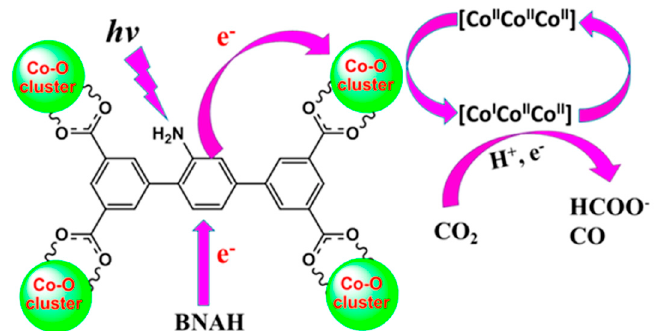
Figure 12. The mechanism of photocatalytic CO 2 reduction to HCOO − and CO, in the presence of amine-functionalized Co-MOF [Co 3 (HL) 2 × 4DMF × 4H 2 O] as catalyst and BNAH (1-benzyl-1,4-dihydronicotinamide) as electron donor (Reprinted with permission [157]. Copyright 2018 American Chemical Society).